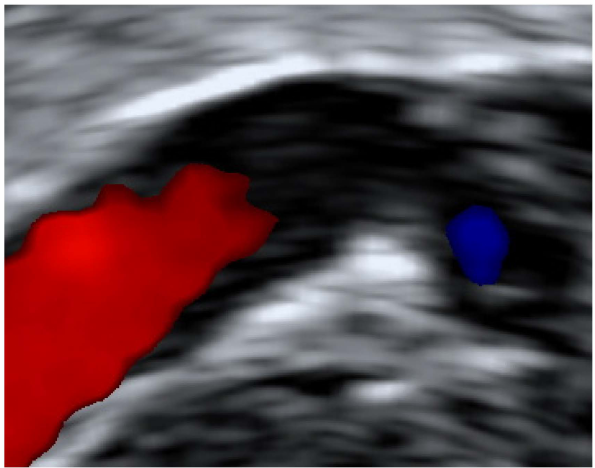
Figure 3. Colour Doppler transvaginal image of fibrosis within uterine